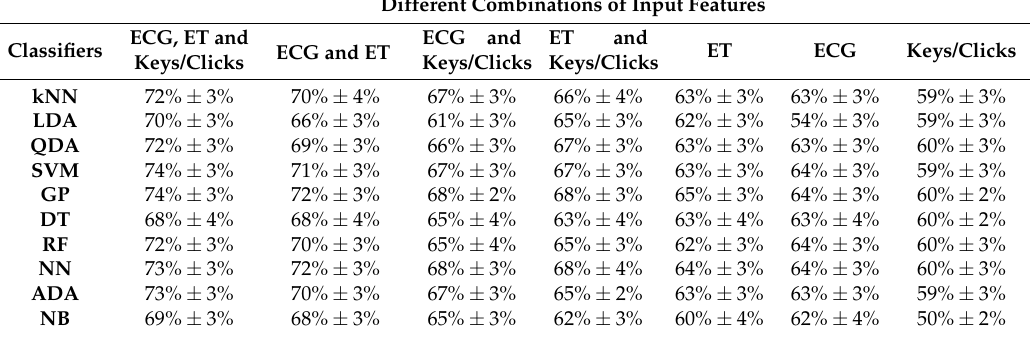
Table 1. Average balanced accuracy results for 20 × 5-fold cross-validations and the 95% confidence interval of two-dimensional inter-subject single-trial classifications including different combinations of input